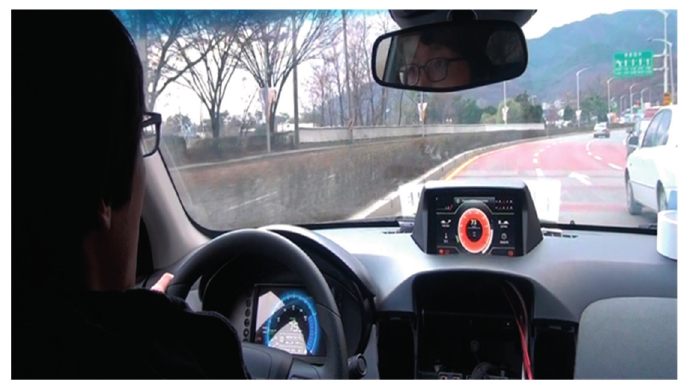
Figure 6. Vehicle test for energy usage efficiency enhancement.